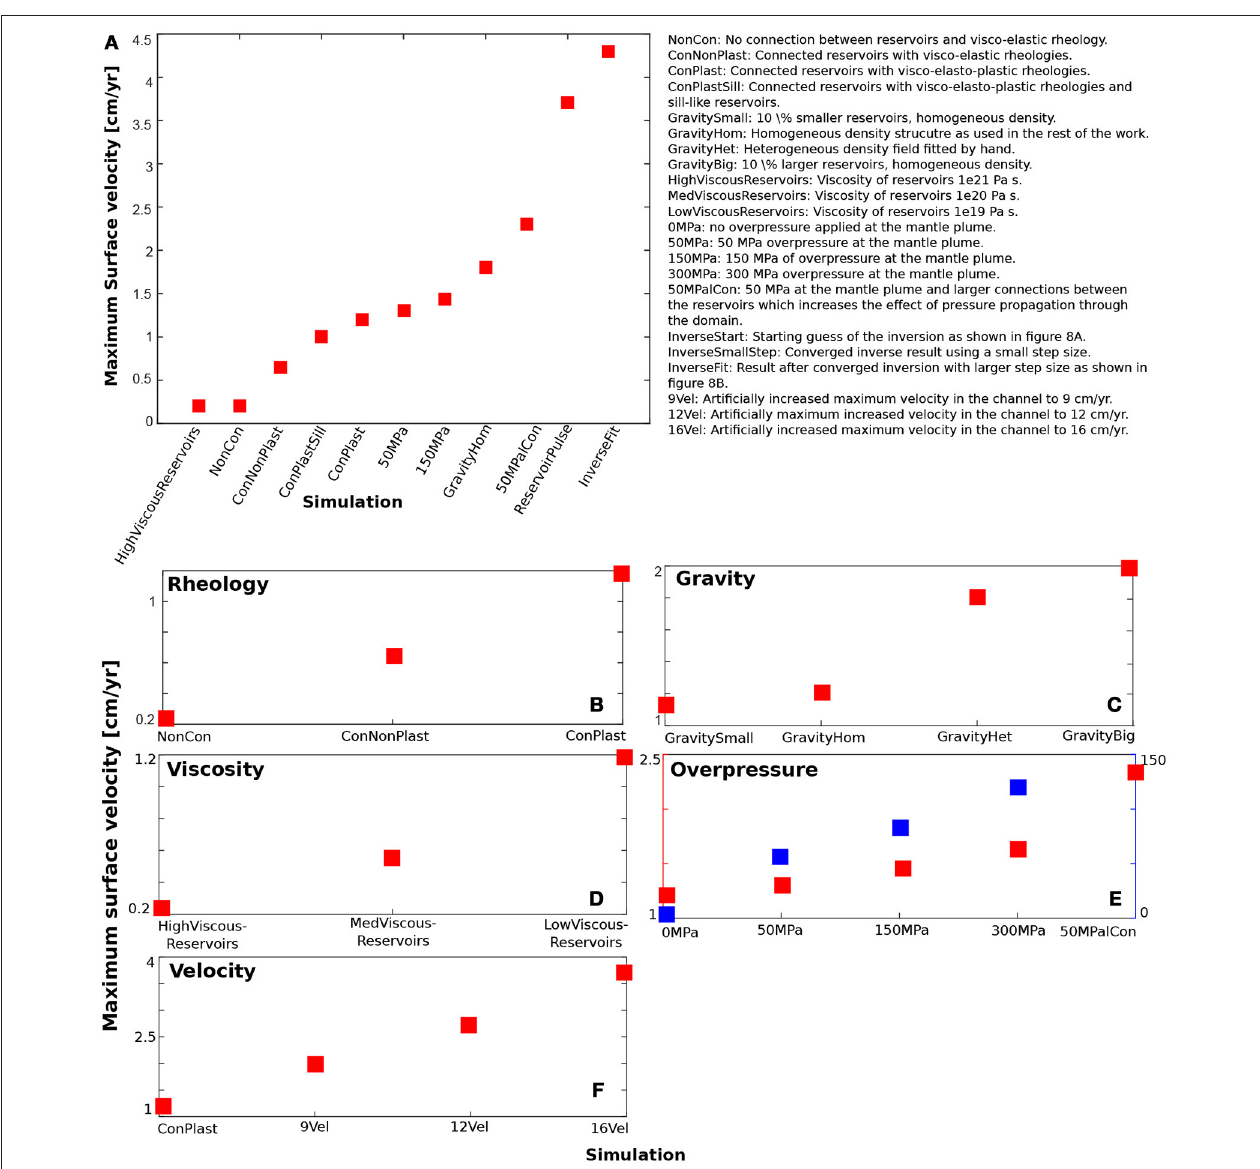
FIGURE 9 | Summary of the impact of the various parameters considered here on the vertical surface velocity. (A) Set of representative simulations and the resulting surface velocities. (B) Effect of rheology. (C) Effect of the different density models on the surface velocity. (D) Viscosity of the magma reservoirs. (E) Effect of overpressure at the mantle plume. Red squares represent the surface velocity. Blue squares show the maximum z-velocity at the boundary where the overpressure is applied (numbers on the right axis). (F) Effect of kinematic internal boundary condition between the reservoirs simulating inflation and deflation between the upper and lower reservoirs, respectively. The largest effect on the vertical surface velocity is caused by changing the kinematic boundary